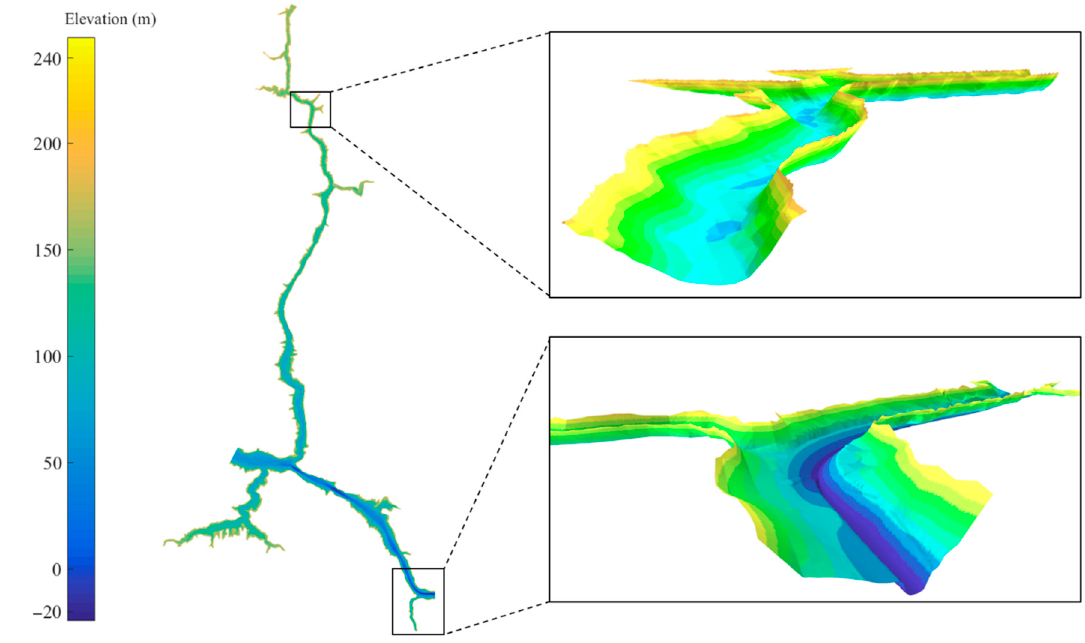
Figure 7. A new DEM generated by the proposed algorithm for the TGR computational domain. The upper inset above displays the downstream view of the meandering Xiangxi River, and the lower one shows the upstream view at the end of the Yangtze River.